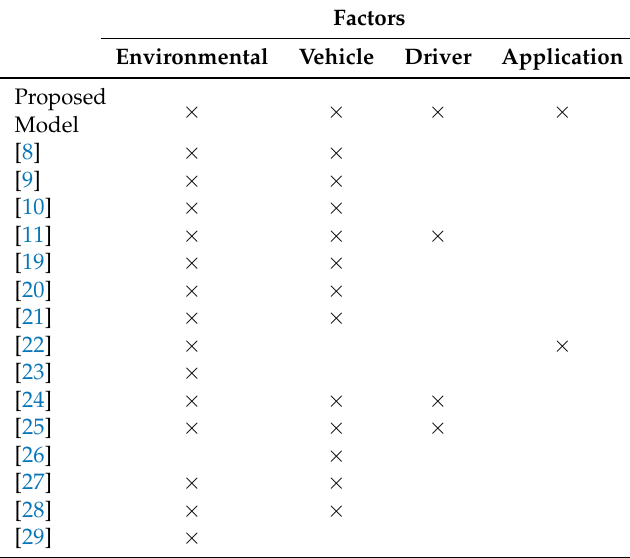
Table 14. Classification of existing